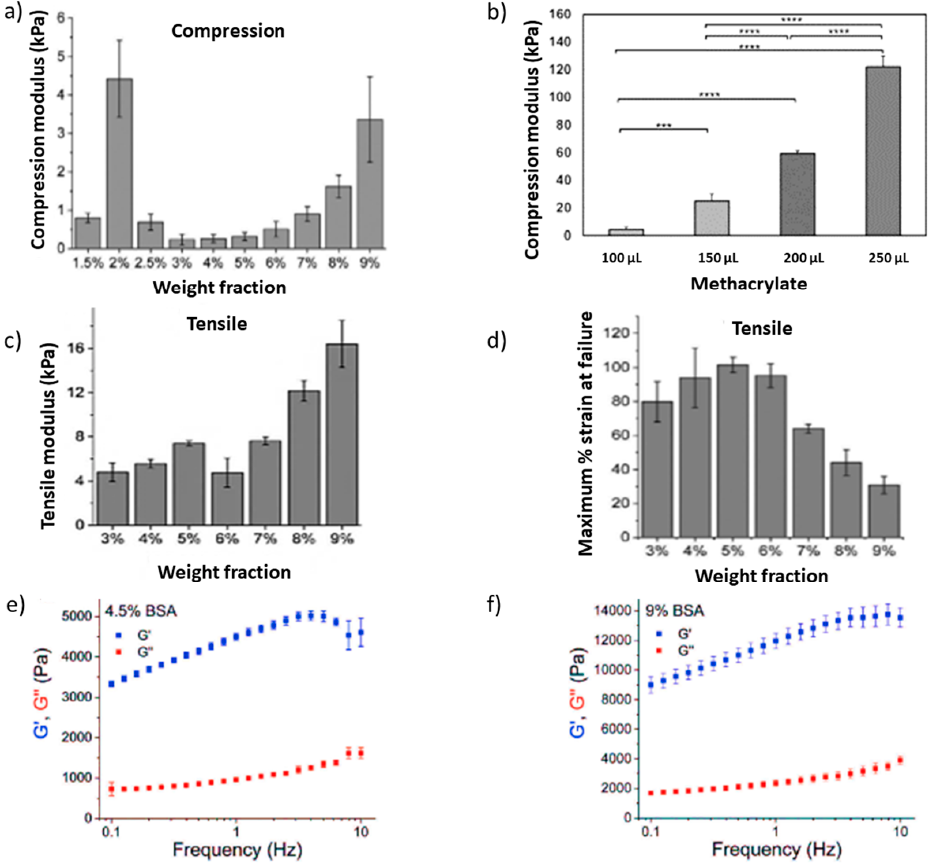
Figure 4. Mechanical properties of albumin hydrogel. ( a ) The effect of albumin concentrations on the compression modulus of hydrogels [30]. ( b ) The compression modulus is affected by the addition of different amounts of methacrylate to 5 mL of 20% albumin solution ( w / v ) and by the level of cross-linking [41] **** p < 0.0001, *** p < 0.001. ( c , d ) show the tensile strength of hydrogels containing different amounts of albumin [30]. Frequency-dependent rheological properties of hydrogels containing 4.5% ( e ) versus 9% ( f ) albumin [30]. G’: storage modulus G’’: loss modulus.